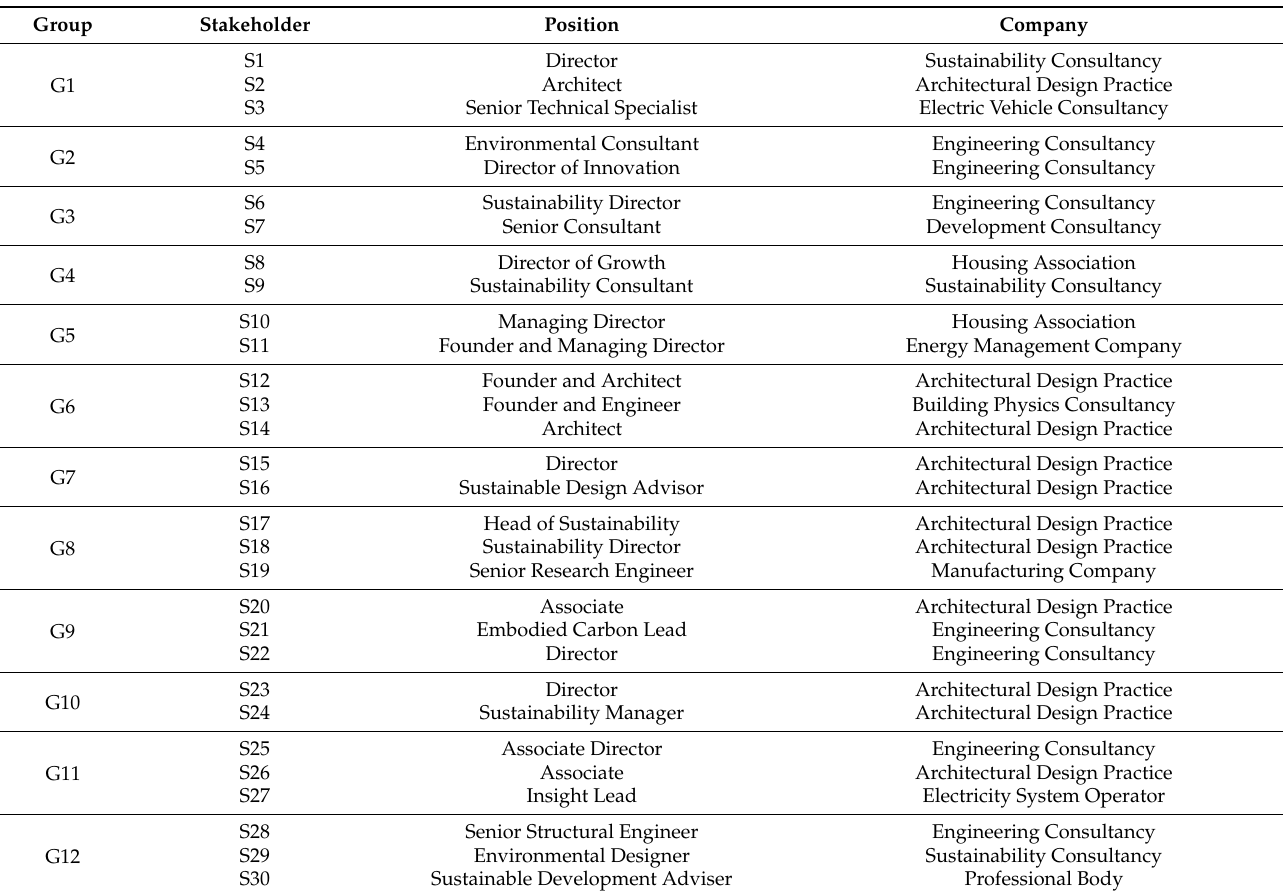
Table A1. Anonymised list of